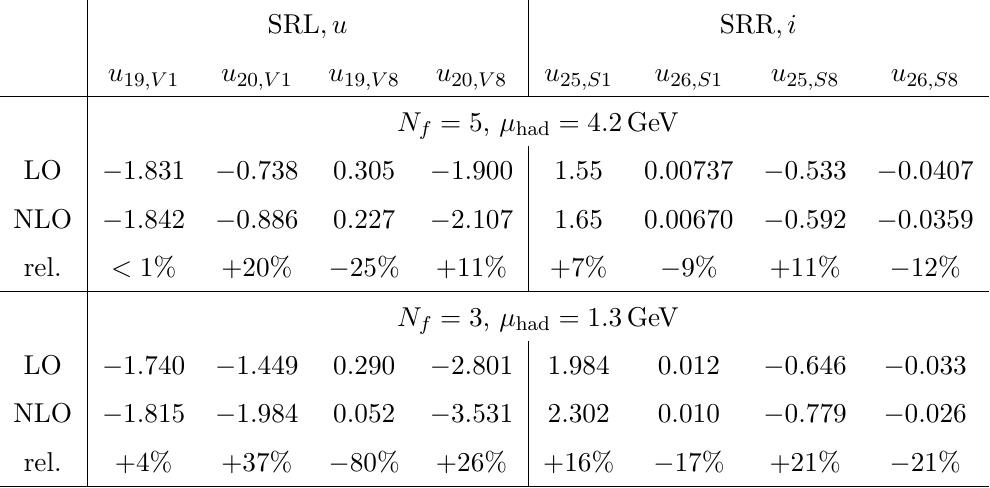
Table 1 . The impact of NLO QCD corrections on u ab ( µ, µ ew ) for the SRL , u and SRR , i sub-sectors in the N = 5 theory for µ = 4 . 2 GeV and N = 3 theory for µ = 1 . 3 GeV. The relative impact f had f had (cid:1) is displayed in the rows labelled by is indicated w.r.t. to | u , i.e. (cid:0) | u NLO | / | u LO | − 1 ab | ab ab